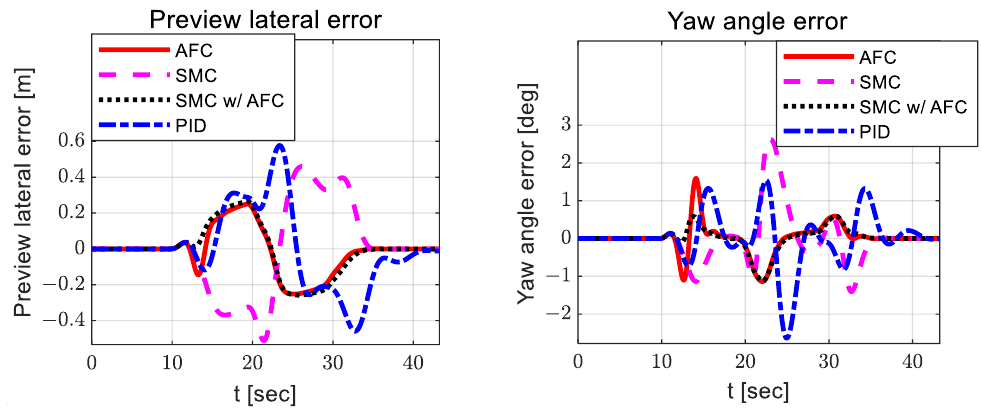
Figure 9. Results: path-tracking control errors (lateral— left ; yaw angle— right ) for the curved path